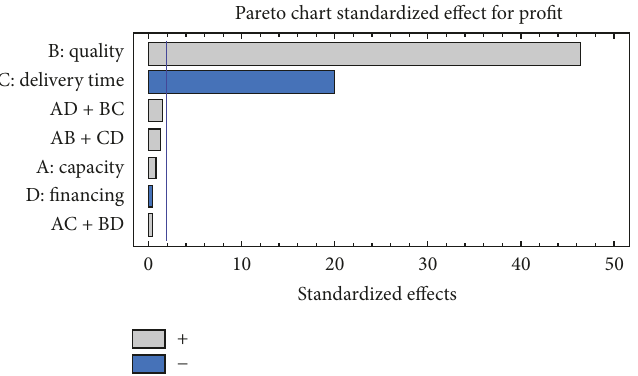
Figure 4: Standardized Pareto for the profit of factors.